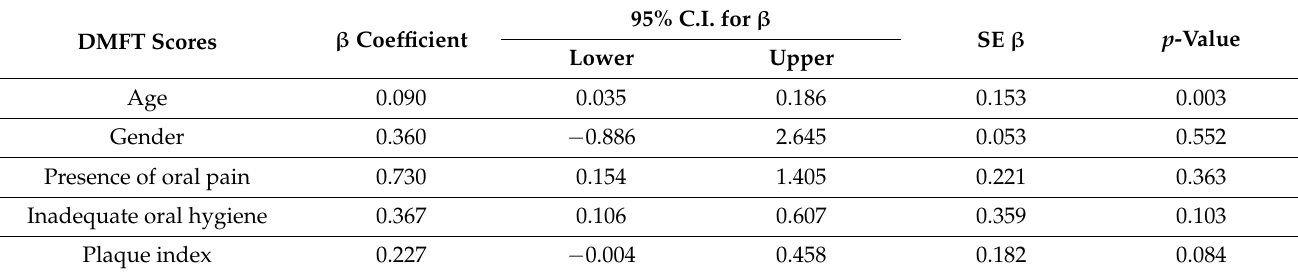
Figure 2. Percentage of the healthy, decayed, missing, and filled teeth on a total of 3023 patients evaluated. Table 1. Multiple linear regression results for DMFT scores.